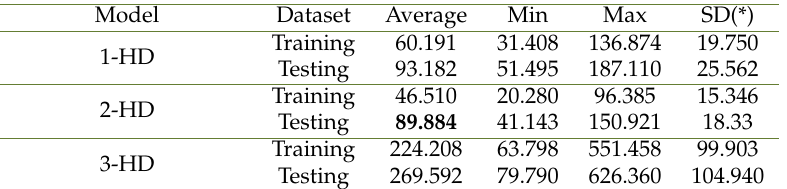
Table 6. Summary of the 1000 simulations using RMSE criteria Model